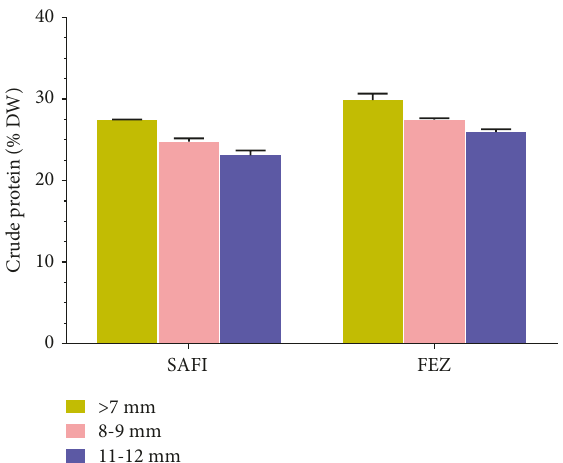
Figure 6: Carotenoids content of three different sizes of Moroccan Capparis spinosa seeds collected from FEZ and